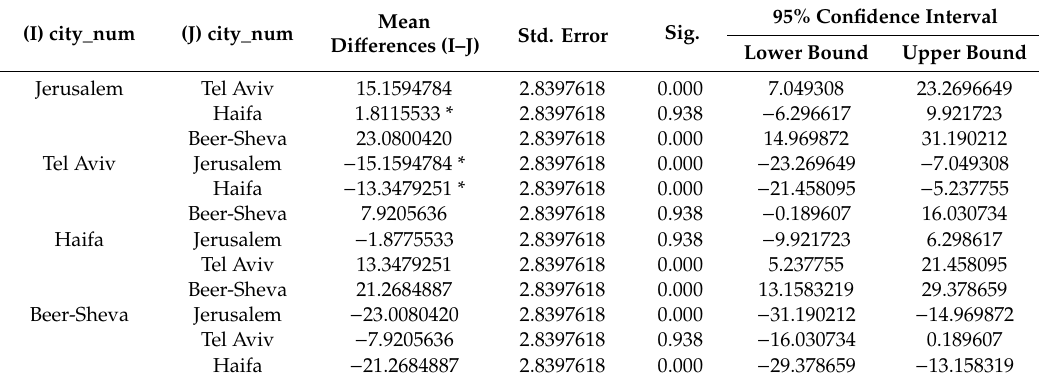
Table A2. ANOVA Results and a Post Hoc Analysis.